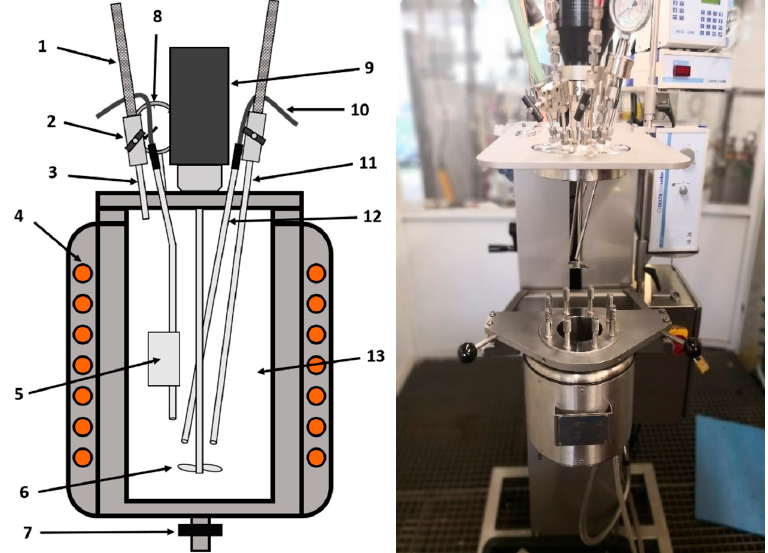
Figure 4. Sketch and picture of the autoclave: 1. Pressure pipe (Stahlflex); 2. needle valve; 3. tube for gas exhaust; 4. reactor shell with heating and cooling; 5. temperature sample head; 6. propeller mixer; 7. outlet valve; 8. analog manometer; 9. motor for the magnetic coupled stirrer; 10. cable for the measurement cutting site; 11. gas inlet; 12. testing rode for pressure; 13. working volume. The values of temperature and pressure during carbonation are presented at Figure 5.